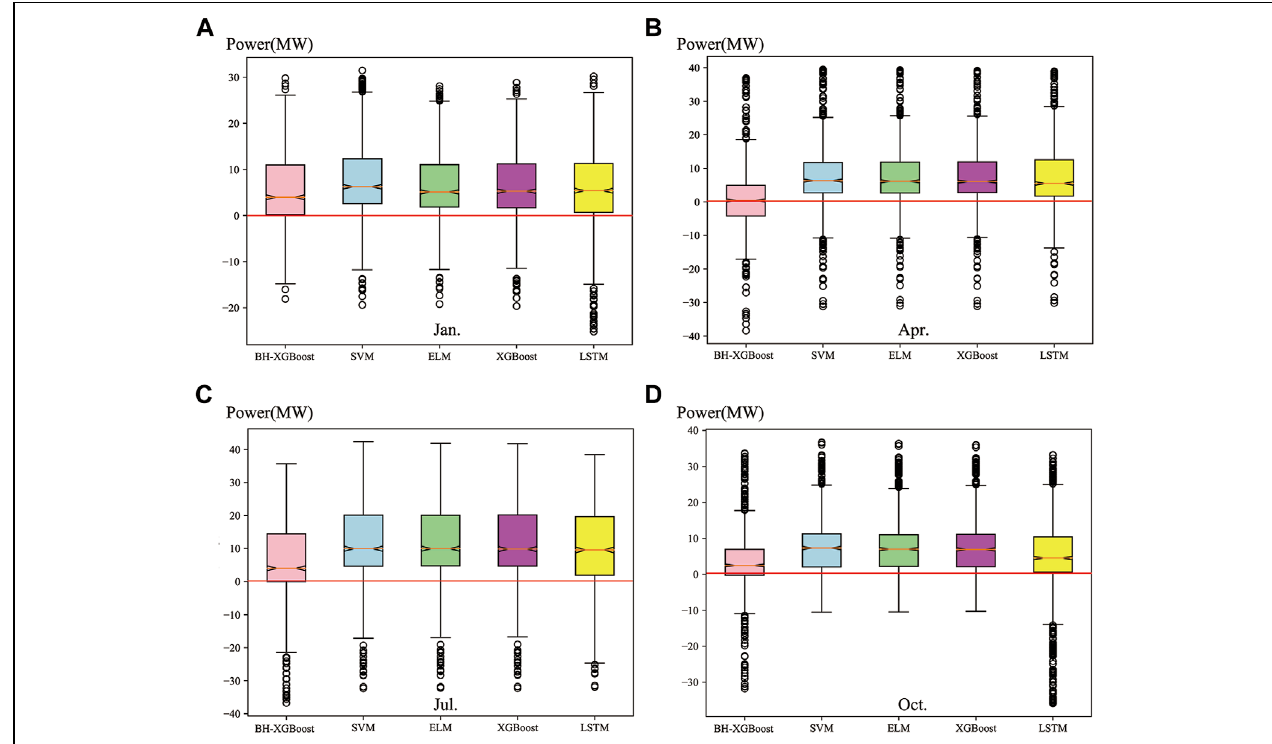
FIGURE 6 | The residual boxplot of the result obtained by the different methods against the observation for different cases: (A) Jan., (B) Apr., (C) Jul., (D) Oct.